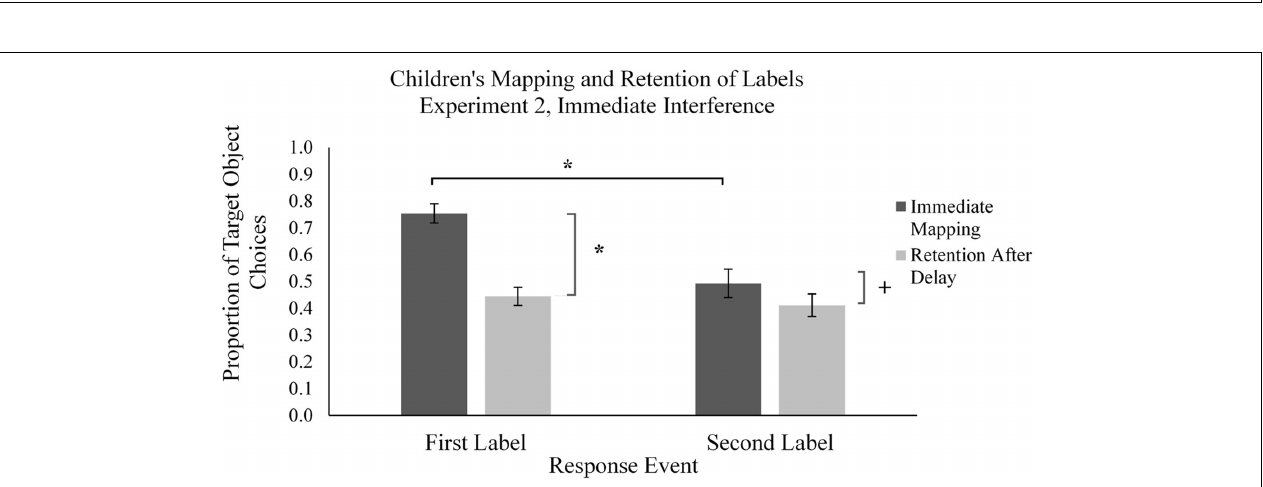
FIGURE 5 | Examples of stimuli used in the learning phases of Experiment 2. In the three conditions of Experiment 2, protocol of Experiment 1 was replicated (Immediate Interference), the second mapping event for each object occurred after a delay (Delayed Interference), or no second mapping event occurred (No Interference), to examine the potential role of interference in children’s retention of word mappings.